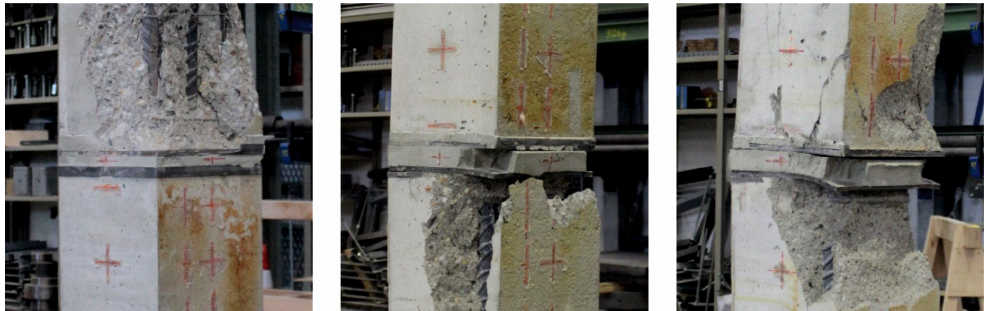
Figure 5. Test specimens after failure: S 9.2 ( left ), S 9.3 ( middle ) and S 9.6 ( right ).